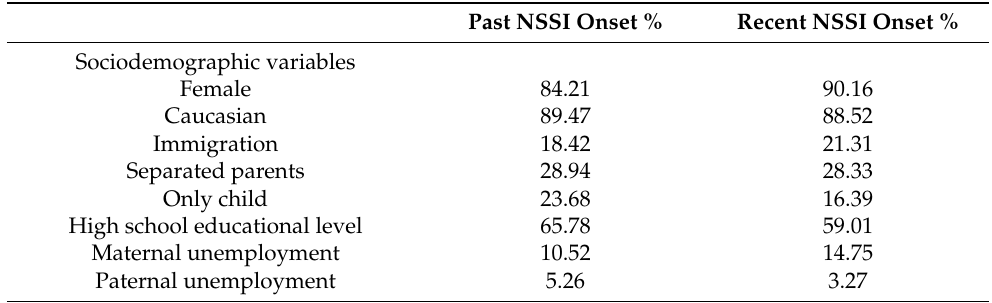
Table 1. Sociodemographic and clinical features of patients with past and recent NSSI